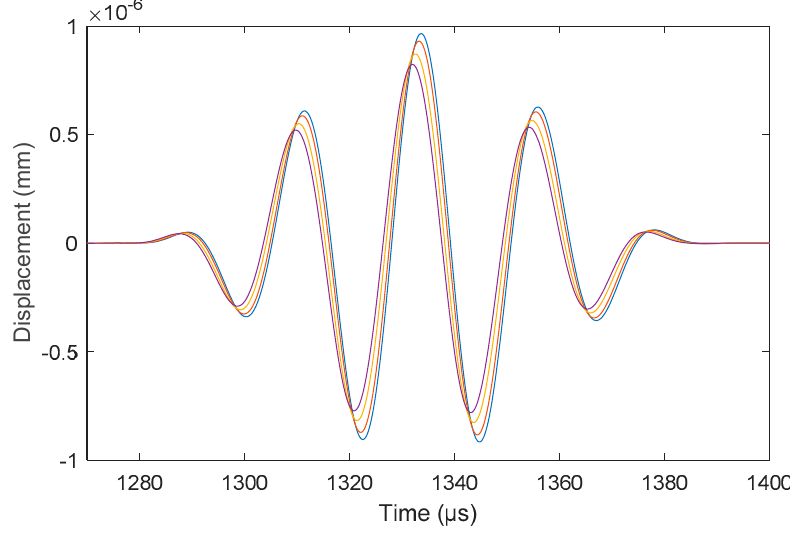
Figure 9. Comparison of FEA pitch-catch signal at different fouling thicknesses.